Question: In one sentence, what is this figure communicating?
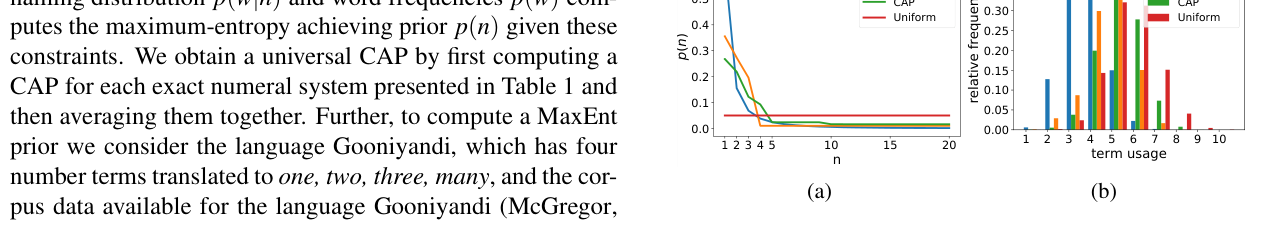
Answer: a) The need probabilities, or priors, used. b) Rel- ative frequency of term uses over sender-listener pairs using the linear reward function and varying the need probability. The more left-skewed the need probability is, the fewer terms are generally used by the agents.